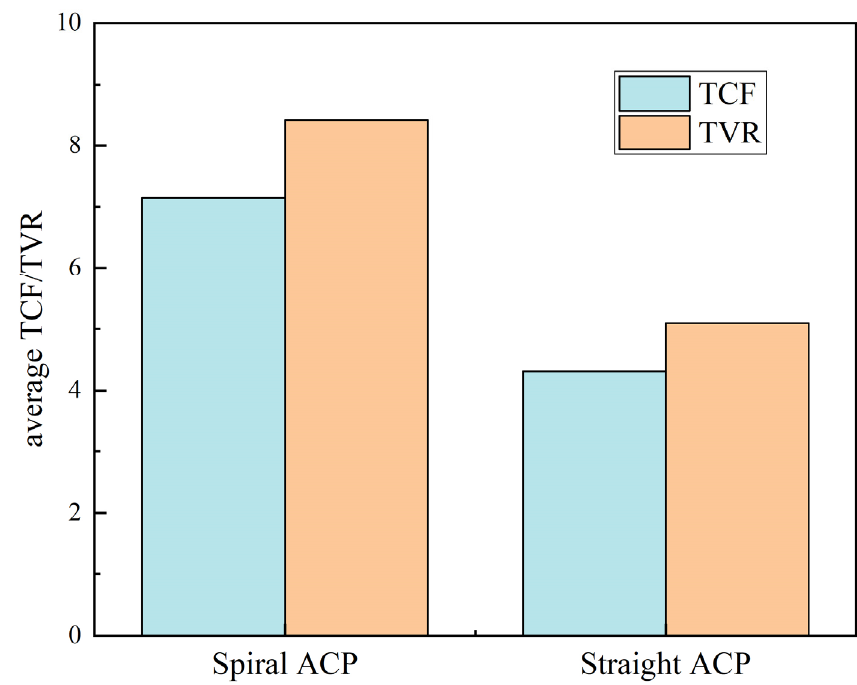
Figure 9. Comparison of TCF and TVR between cases with spiral ACP and straight